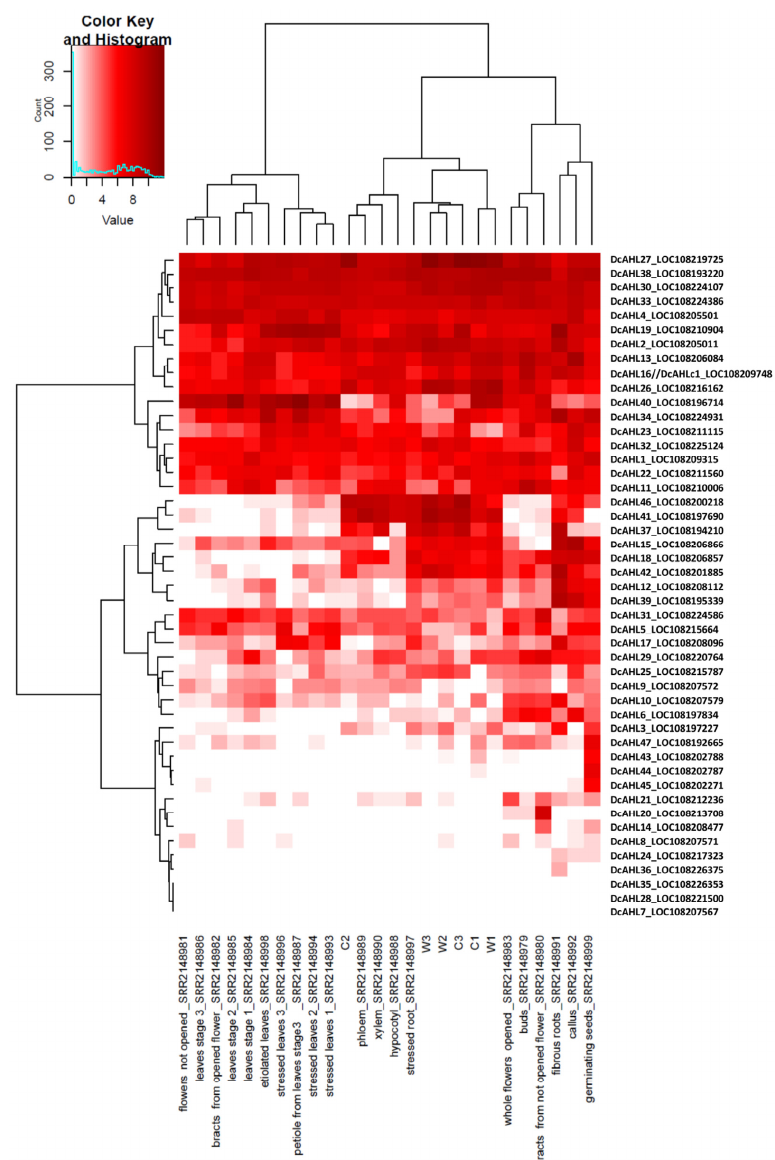
Figure 4. Hierarchical clustering and expression patterns of AHL genes in seedlings (C1, W1), developing (C2, W2) and mature (C3, W3) roots from cultivated (C) and wild carrot (W) (transcriptome data from [29]) and 20 tissues of the carrot reference line DH1 (germinating seeds, hypocotyl, leaves stage 1, 2, and 3, petioles from leaves at stage 3, stressed leaves stage 1, 2, and 3, etiolated leaves, fibrous root, root xylem, root phloem, stressed root, buds, flowers not opened, whole flowers opened, bracts from not opened flowers, bracts from opened flowers, and callus; transcriptome data from [20]). The color scale represents log2(normalized_reads + 1) values.